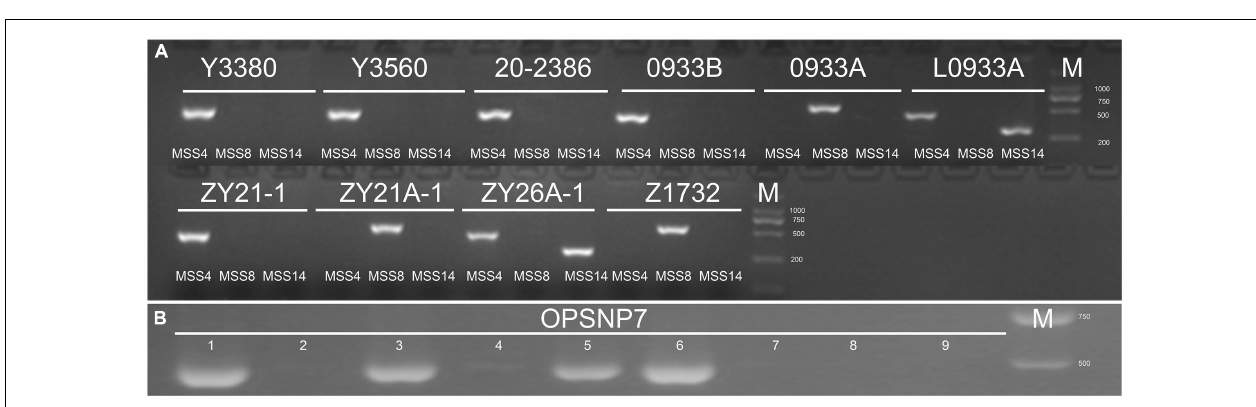
the sterile progeny were identified as pol CMS, that is, cytoplasmic changes occurred after